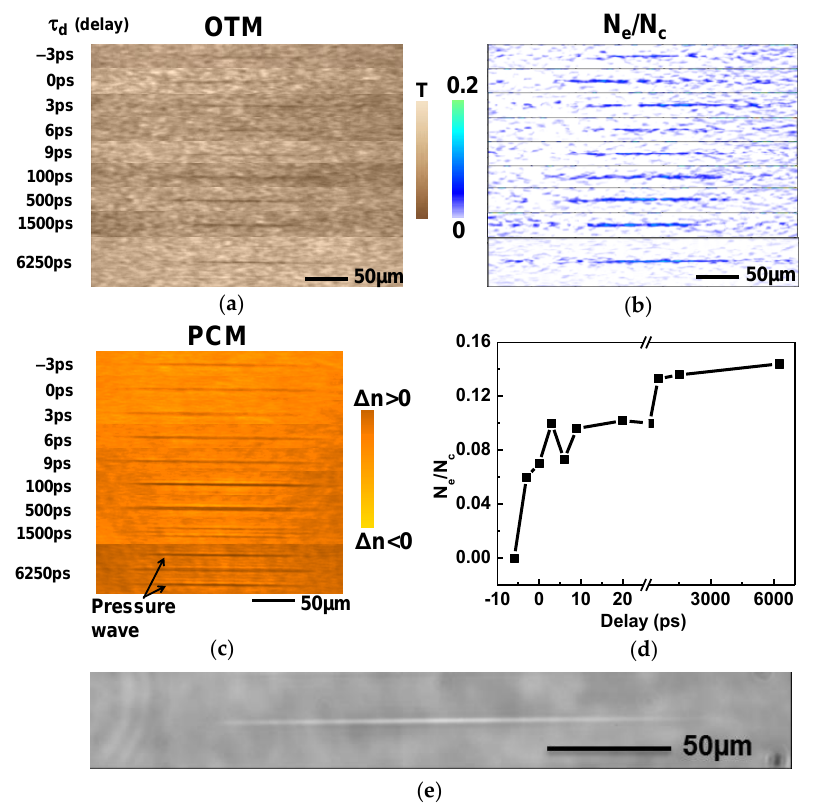
Figure 7. ( a ) Time-resolved optical transmission microscopy imaging of the relaxation of the carrier plasma produced by a single-shot 1 µ J, 4ps Bessel laser pulse focused into Ge 15 As 15 S 70 ; ( b ) Time- resolved imaging of plasma electron density with spatio-temporal excitation profiles; ( c ) Time- resolved phase contrast microscopy imaging; a pressure wave is clearly visible around 6 ns; ( d ) Av- eraged plasma electron density dynamics as function of the delay time between pump and probe; ( e ) Permanent Type II change produced in single-shot regime by a 1 µ J, 4 ps Bessel laser pulse focused into Ge 15 As 15 S 70